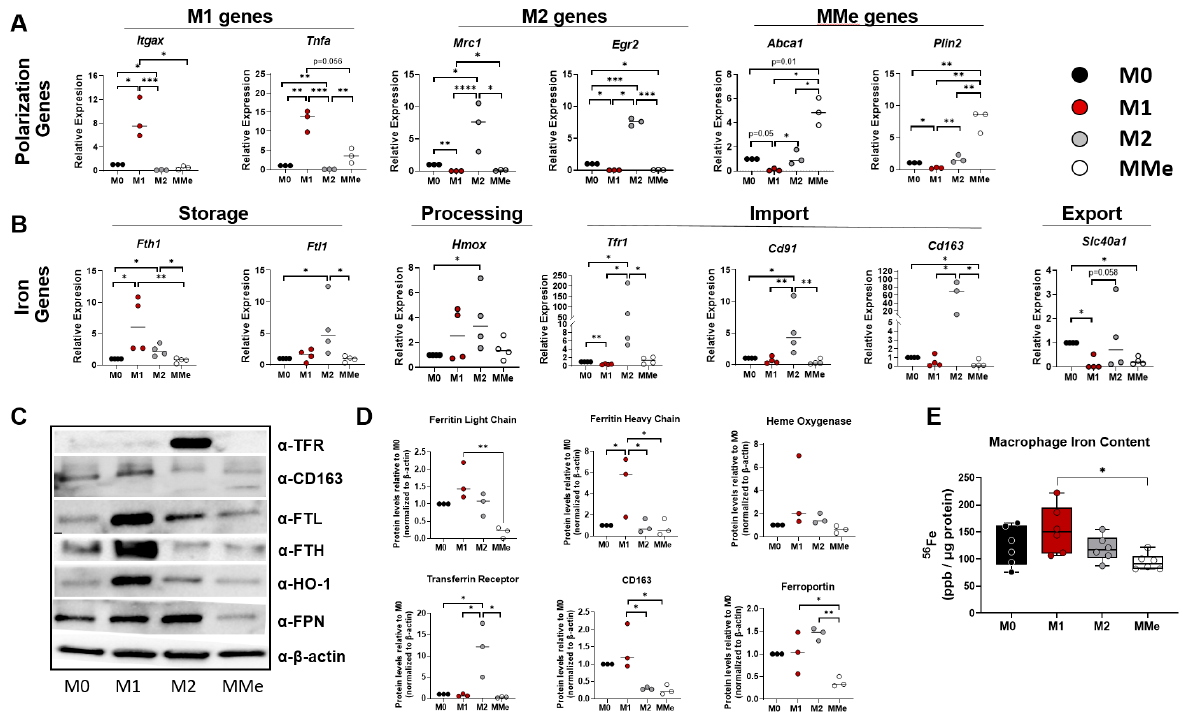
Figure 1. Loss of iron-related gene and protein expression in obesogenic macrophages . Primary bone marrow-derived macrophages (BMDMs) were differentiated and polarized into unpolarized (M0), M1, M2, and MMe states. ( A ) Expression of polarization genes. ( B ) Expression of iron-han- dling genes. ( C , D ) Western blot for iron-handling proteins and their quantification. ( E ) Iron ( 56 Fe) content as measured by ICP-MS in polarized BMDMs. Statistics were performed using one-way ANOVA with Bonferroni or Tukey’s post-hoc tests for multiple comparisons. * p < 0.05; ** p < 0.01, *** p < 0.01, **** p < 0.001.